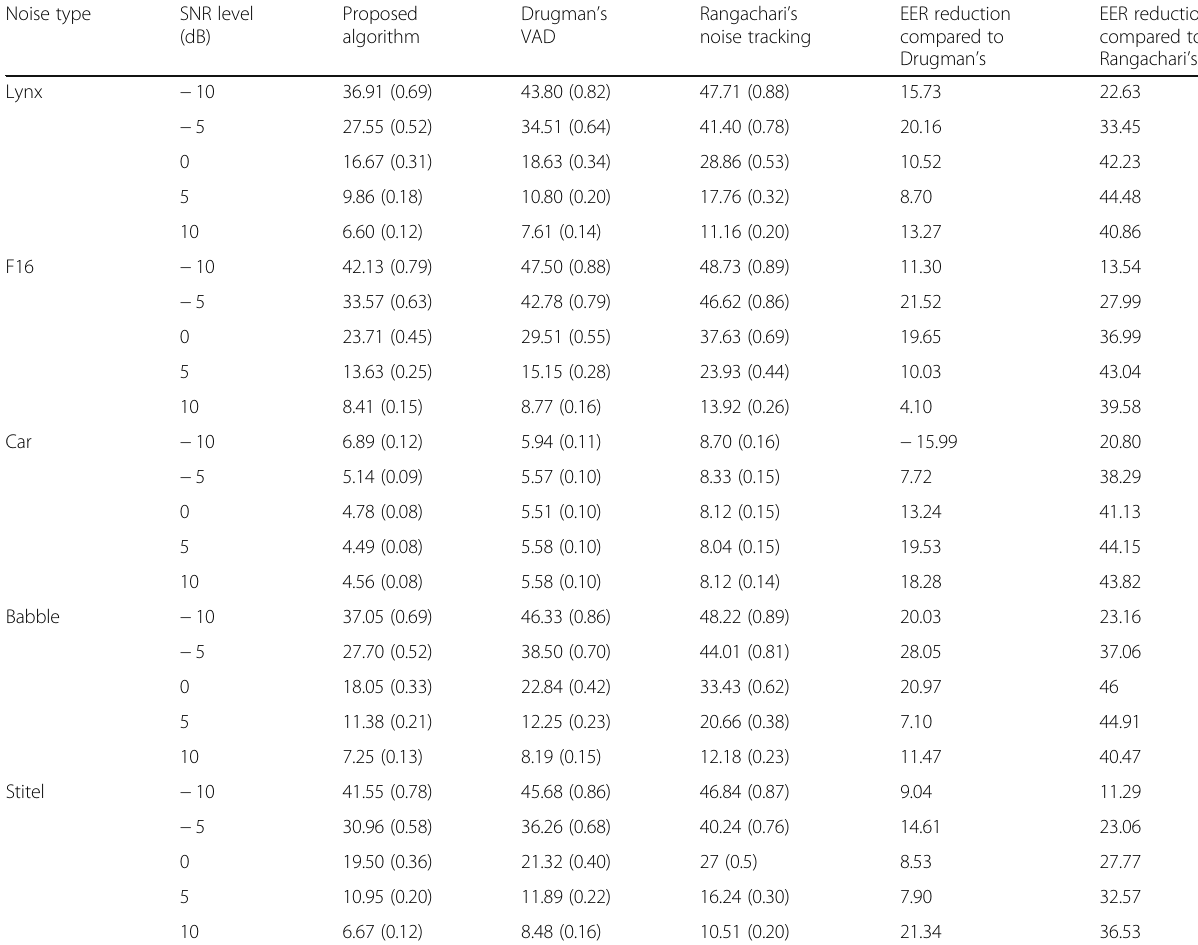
Table 2 Female speaker verification results of GMM-UBM method in terms of percent EER (minDCF) for the proposed algorithm, Drugman ’ s VAD method [27], and Rangachari ’ s noise tracking method [21]. The last columns show the relative percent EER reduction rates compared to Drugman ’ s VAD and Rangachari ’ s method, respectively